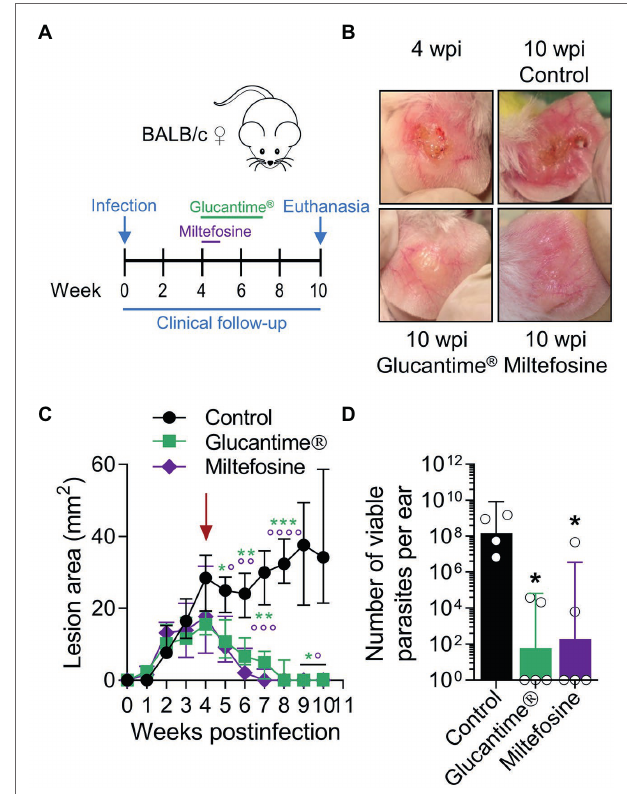
FIGURE 6 | Using the L(V)p -BALB/c model to investigate pharmacological interventions. BALB/c mice were infected id in the ear with 10 5 stationary promastigotes and lesion development monitored weekly (A) . Once lesions were established at the week 4 postinfection ( B , left upper corner ; C , arrow ), mice were treated ip with Glucantime ® (500 mg/kg, once a week, 4 weeks) or orally with Miltefosine (20 mg/kg/day, five consecutive days) as indicated (A) . Representative photographs taken at the indicated timepoints are shown (B) . The therapeutical effect of the agents was clinically monitored measuring the size of the lesions during the subsequent weeks (C) ; asterisks and small circles correspond to p - values from the statistical test comparing control versus Glucantime ® and Miltefosine, respectively. The burden of viable parasites in the ears at the end of the experiment (week 10 postinfection) was analyzed by a limiting dilution assay (D) . Data in (C,D) are presented as the median ± interquartile range ( n = 5–12 mice) and the geometric mean ± 95%IC ( n = 4–5 mice), respectively. wpi: weeks postinfection. * p < 0.05, **p < 0.01, *** p < 0.001, ****p < 0.0001 (Mixed-effects analysis with Geisser–Greenhouse correction and Bonferroni’s multiple comparisons post-hoc test for multiple comparison through time; Kruskal–Wallis test with Dunn’s multiple comparison post-hoc test). A repetition chemotherapy experiment with Glucantime ® in which an extended clinical follow-up was performed, indicated that remaining mild erythema/swelling observed in some animals at week 10 postinfection completely resolved within the following 2–3 weeks and only a rough/bright clear appearance, most likely representing scarification, was observed. Results are representative of three independent experiments performed with Glucantime ® , whereas the experiment with Miltefosine was performed only